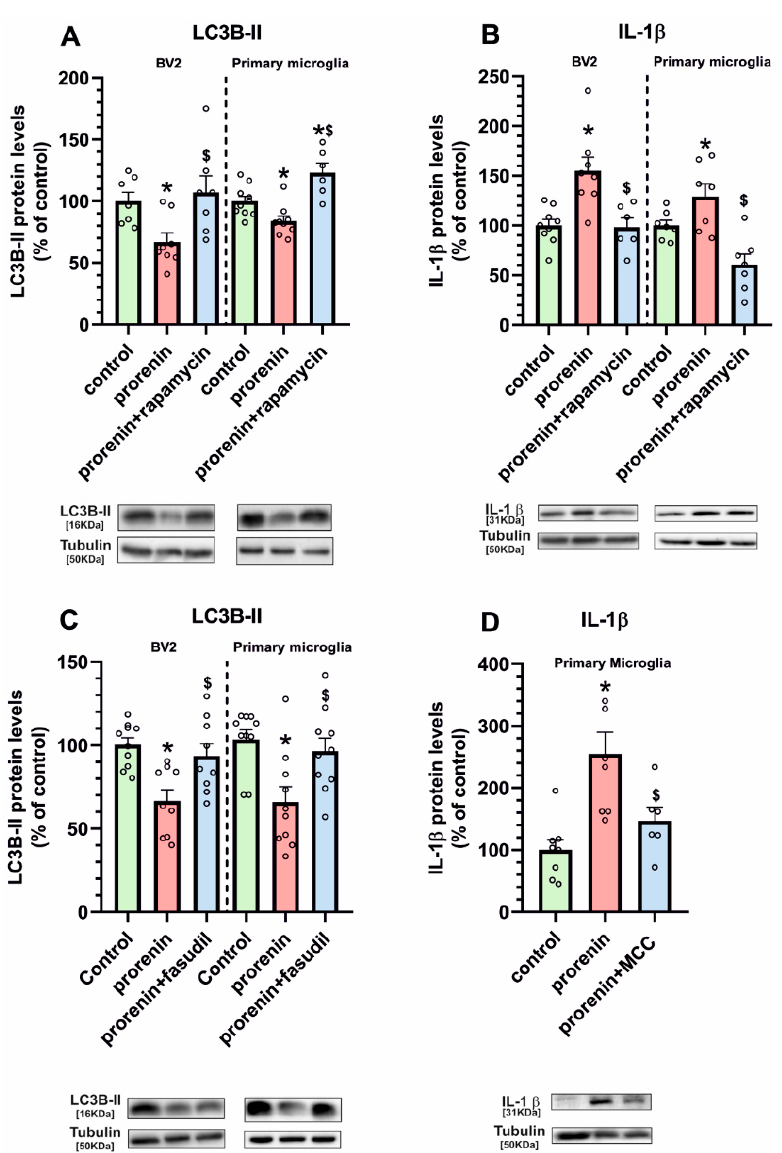
Figure 7. LC3B-II ( A , C ) and IL-1 β ( B , D ) protein expression in BV2 and primary microglia treated or untreated (control) with recombinant prorenin (5 nM) or prorenin and the autophagy inducer rapamycin (1 M) ( A , B ) or prorenin and the ROCK inhibitor fasudil (0.2 µ g/ µ L) ( C ) or prorenin and the inflammasome inhibitor MCC (10 µ M) ( D ), in the presence of losartan (100 nM). Protein expression was measured relative to the tubulin band value and normalized to the values for controls (100%). Data are mean ± SEM. * p < 0.05 relative to the corresponding control, $ p < 0.05 relative to the PR-treated group (One-way ANOVA followed by Holm Sidak post hoc test). IL-1 β , interleukin 1 β ; LC3B, microtubule-associated protein 1 light chain 3 beta; MCC, N -[[(1,2,3,5,6,7-Hexahydro-s- indacen-4-yl)amino]carbonyl]-4-(1-hydroxy-1-methylethyl)-2-furansulfonamide]; ROCK, Rho ‐ kinase.